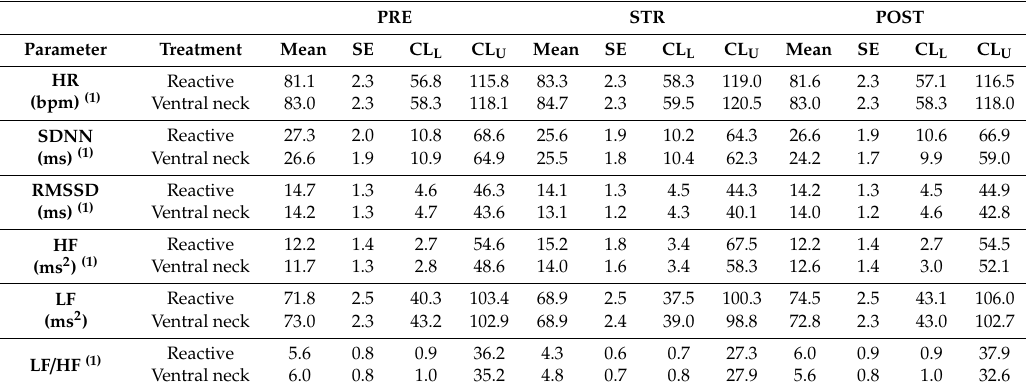
Table 3. Estimated marginal means, standard errors (SE) and lower and upper confidence limits (CL L , CL U ) of HR and HRV parameters of heifers ( n = 27) for each treatment and phase. PRE = pre-stroking, STR = stroking, POST =